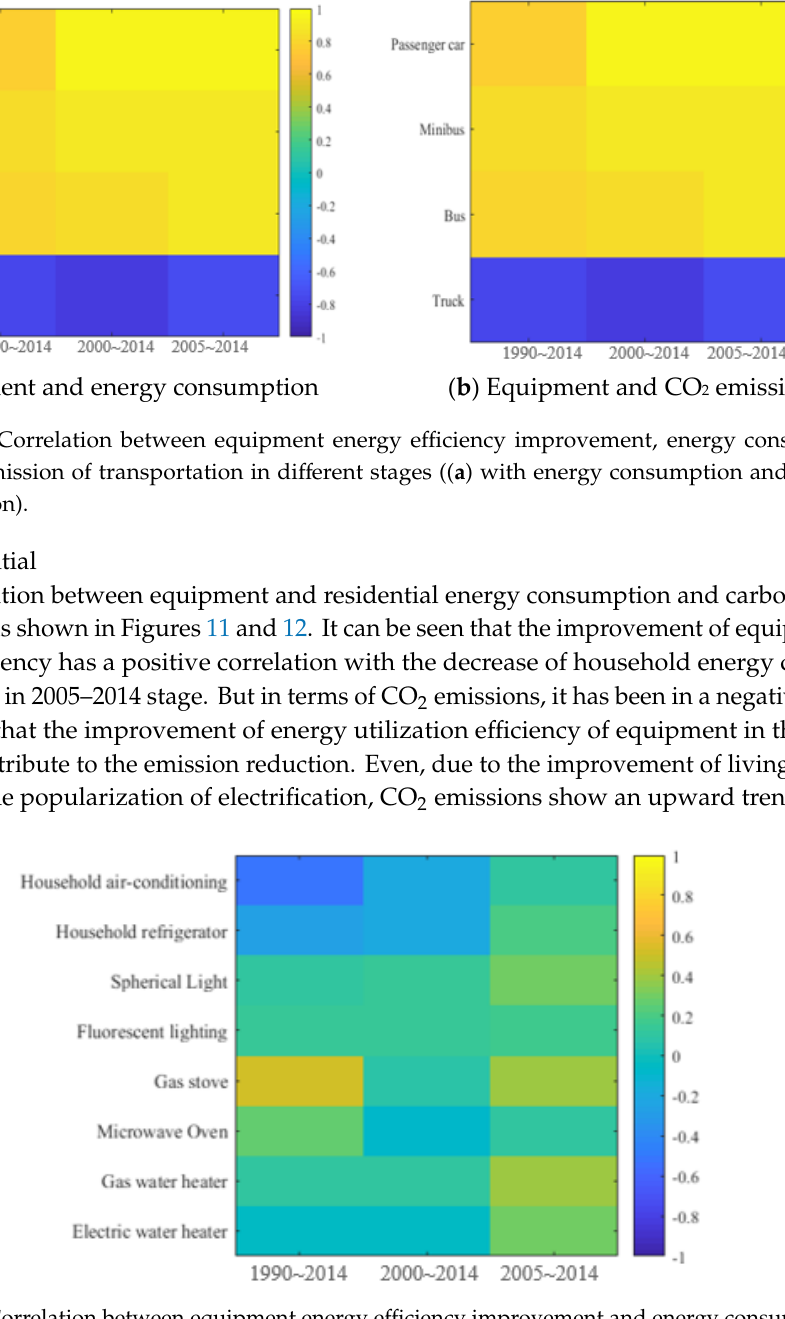
Figure 11. Correlation between equipment energy efficiency improvement and energy consumption of residential in different stages.